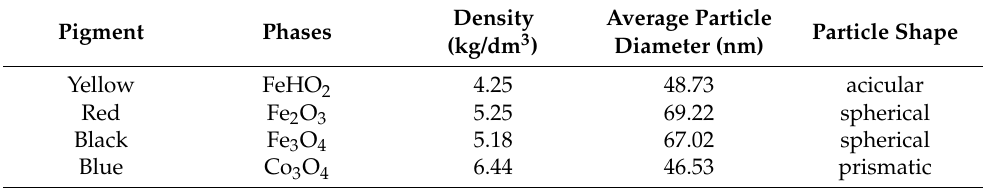
Table 1. Characteristics of yellow, red, black, and blue pigments.